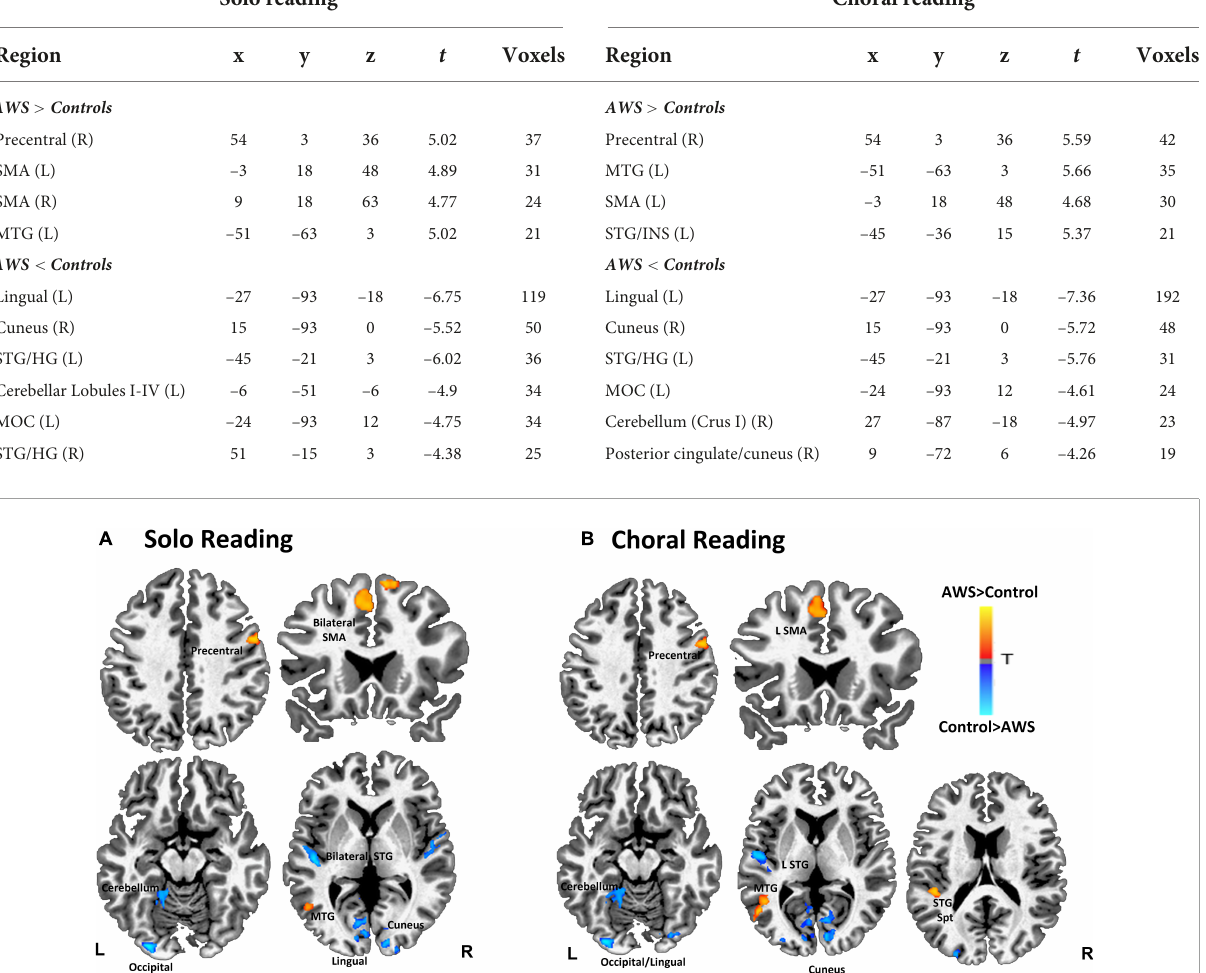
FIGURE1 Contrast between adults who stutter (AWS) and control groups during solo reading (A) and choral reading (B) . Warmer colors represent with significantly greater activity for AWS compared to controls. Statistical map has a threshold at p < 0.05 (corrected).